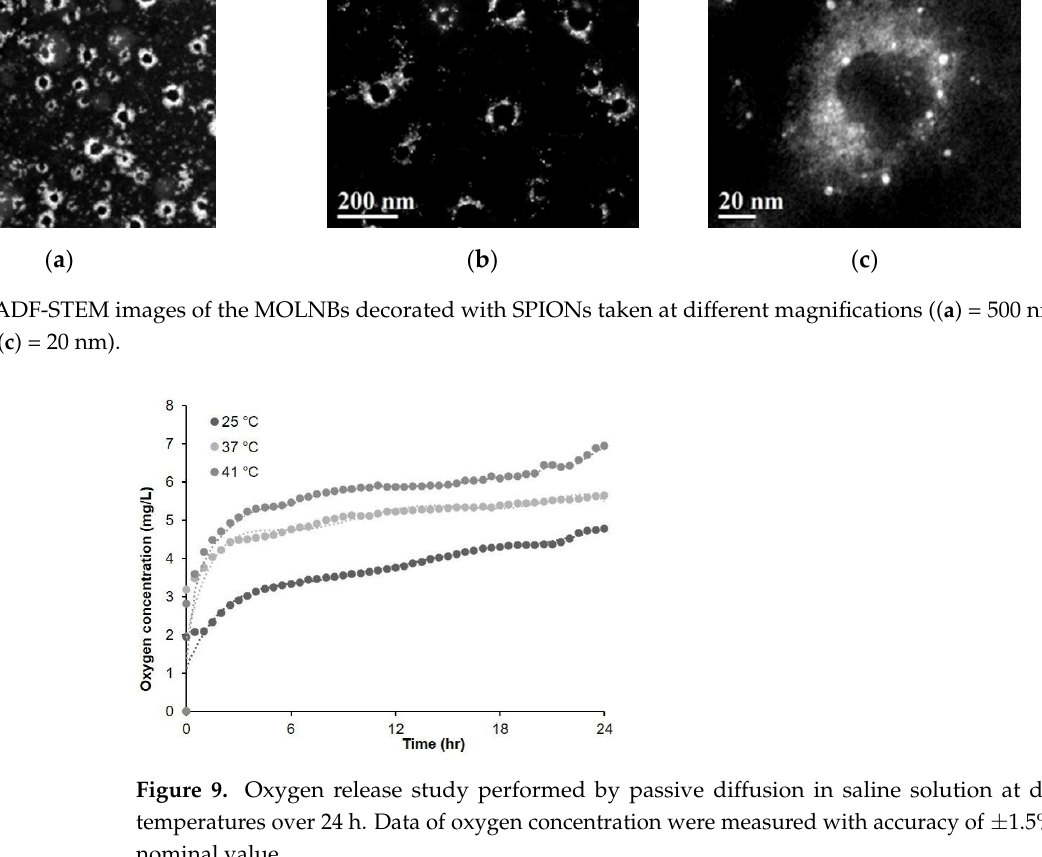
Figure 9. Oxygen release study performed by passive diffusion in saline solution at different temperatures over 24 h. Data of oxygen concentration were measured with accuracy of ± 1.5% of the nominal value.